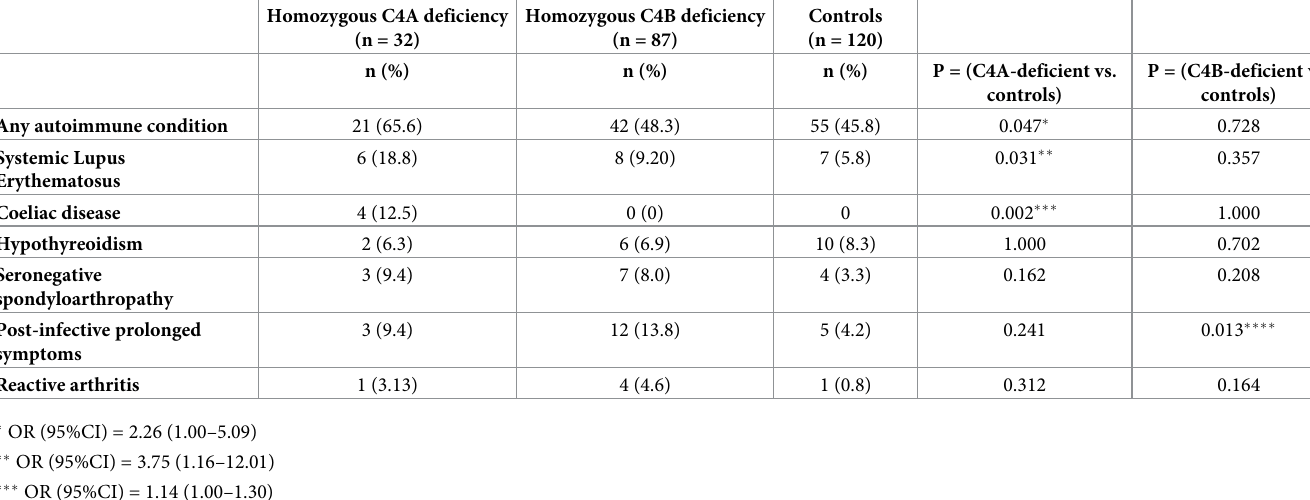
Table 2. Autoimmune conditions in patients with homozygous C4A or C4B deficiency and in patients without C4 deficiencies. Homozygous C4A deficiency (n = 32)